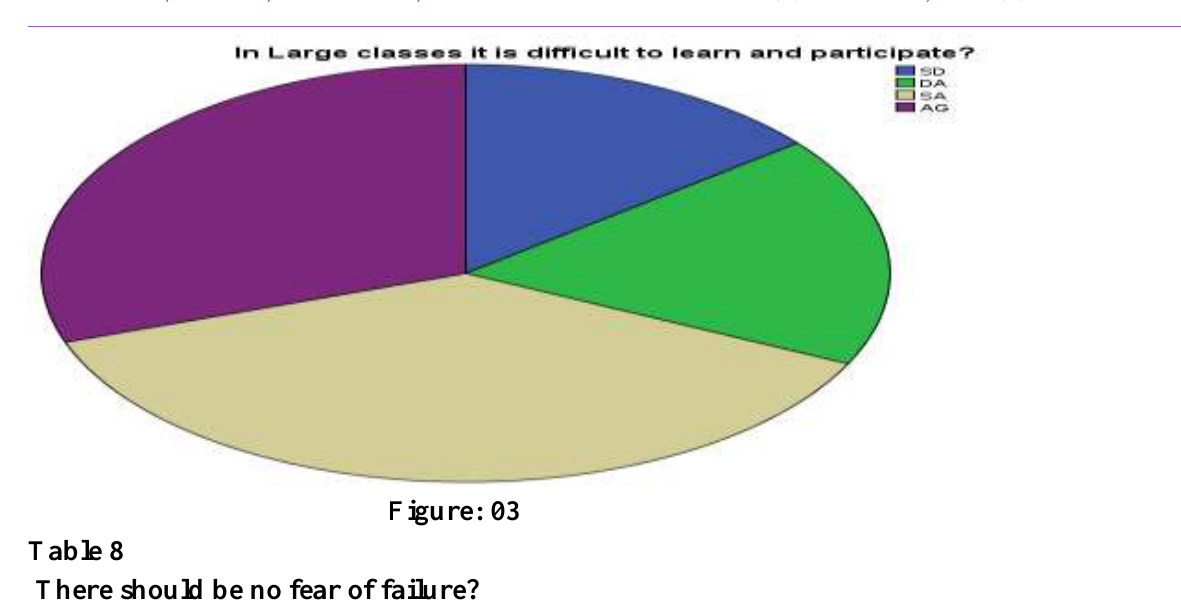
There should be no fear of failure?